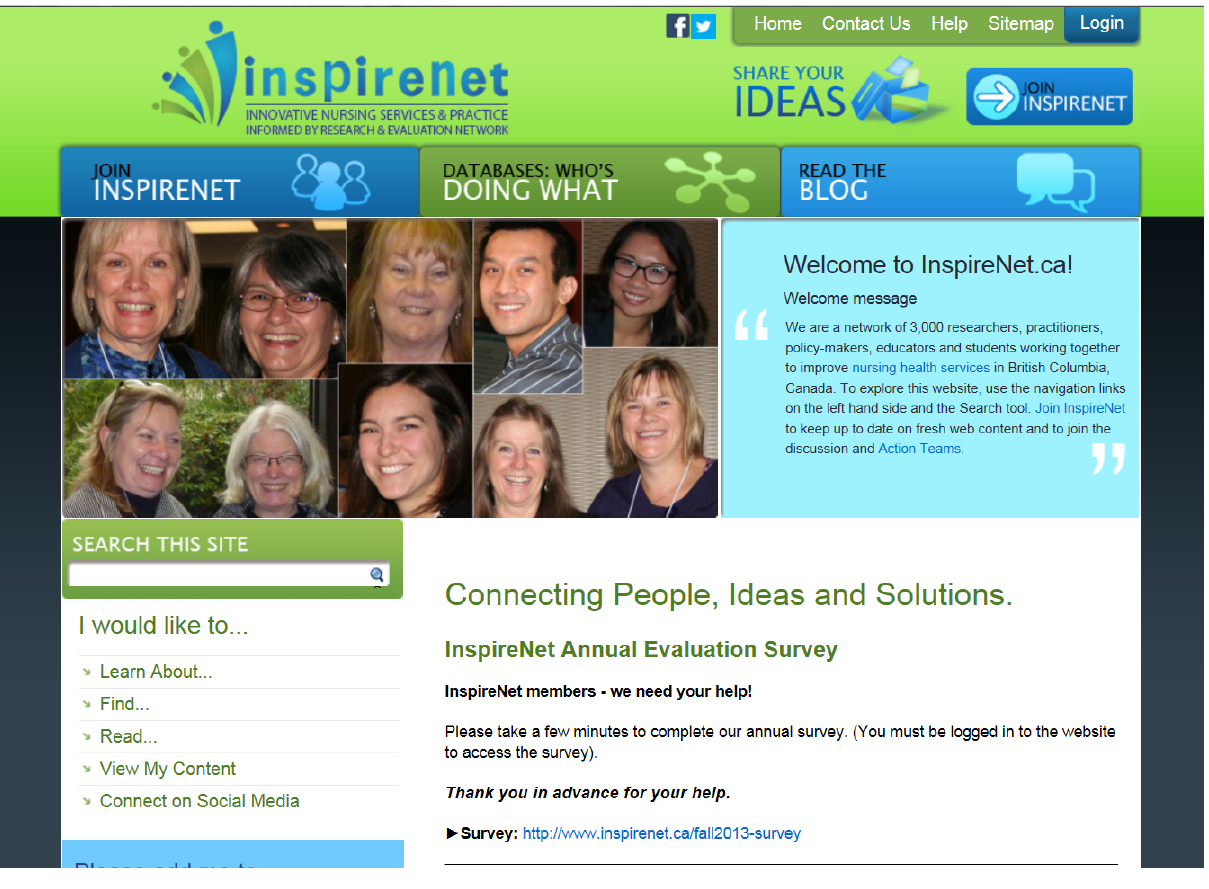
Figure 1. InspireNet home